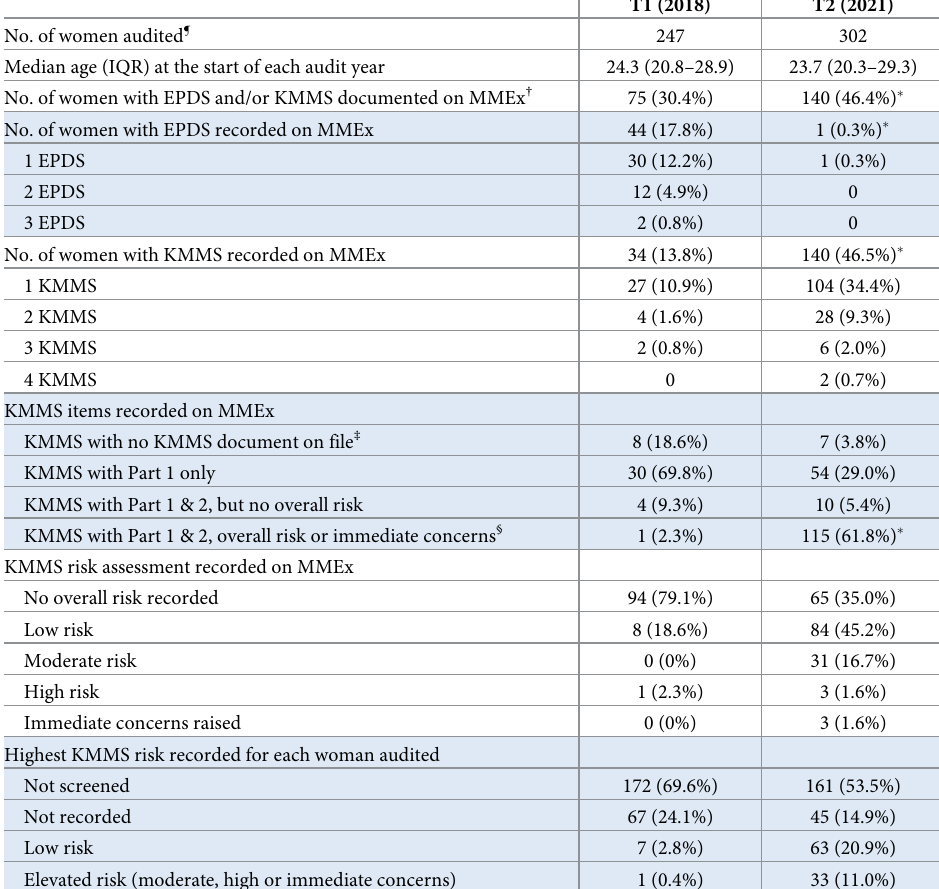
Table 1. Perinatal mental health screening across Kimberley ACCHS pre KMMS implementation project (T1) and in the final project year